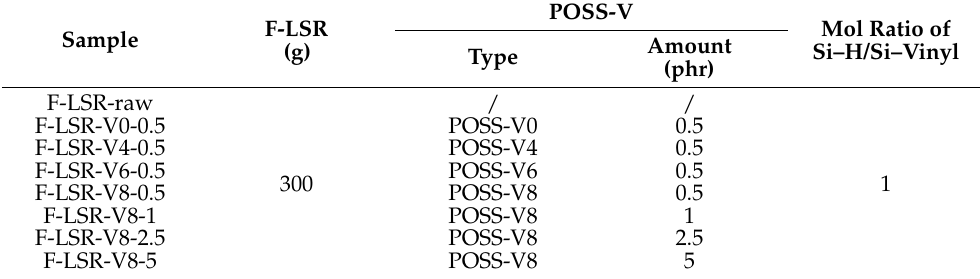
Table 1. Reactant compositions for the preparation of